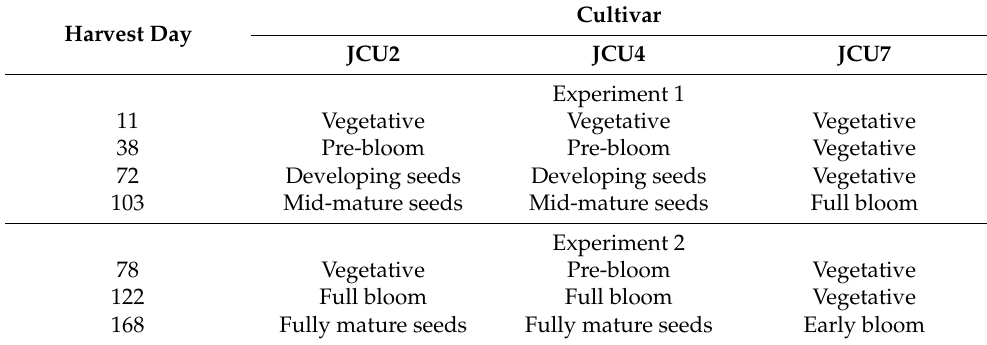
Table 1. Physiological maturity phase of experimental forage at